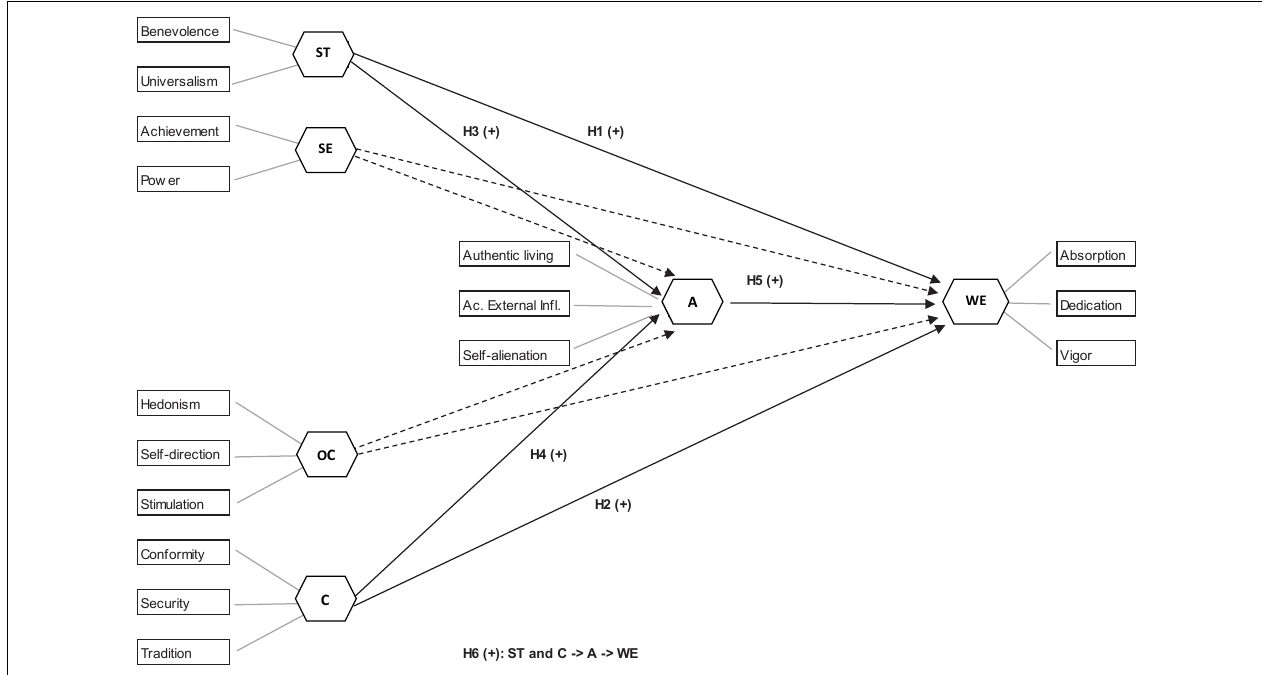
FIGURE 1 | Research model and working hypotheses. A, authenticity; C, conservation; OC, openness to change; SE, self-enhancement; ST, self-transcendence; WE, work